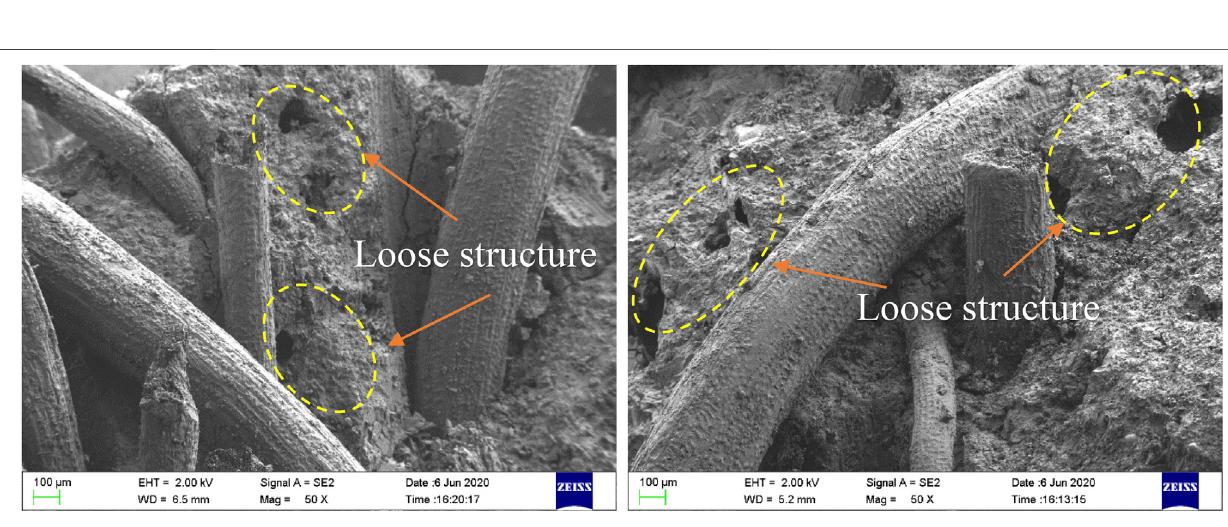
FIGURE 10 | SEM results of MPC with excess